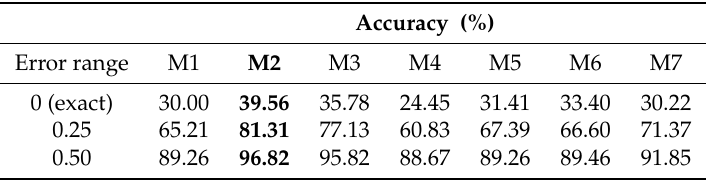
Table 2. Micro-averaged accuracy of individual models considering correct classifications within different human error ranges. Best results are in